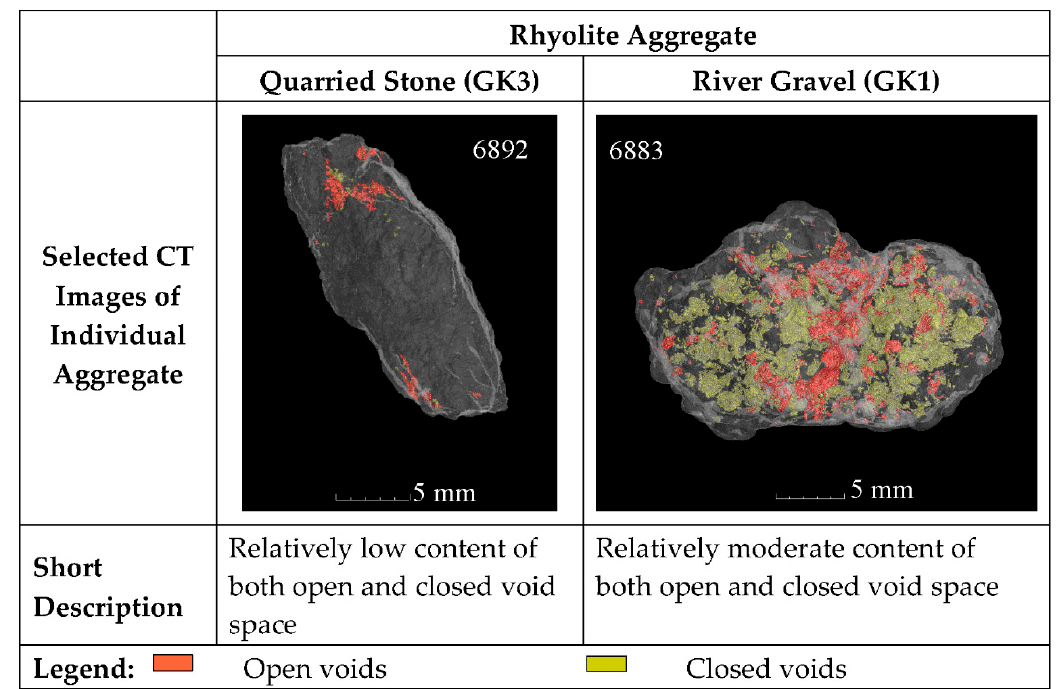
Figure A4. CT-visualizations for individual rhyolite aggregate from quarried stone (GK3) and river gravel (GK1) (based on figures in [10,11]).